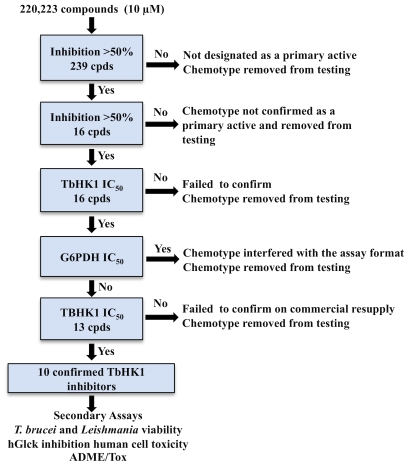
Scheme depicting HTS interrogation of a 220,233 small molecule library for TbHK1 inhibitors.